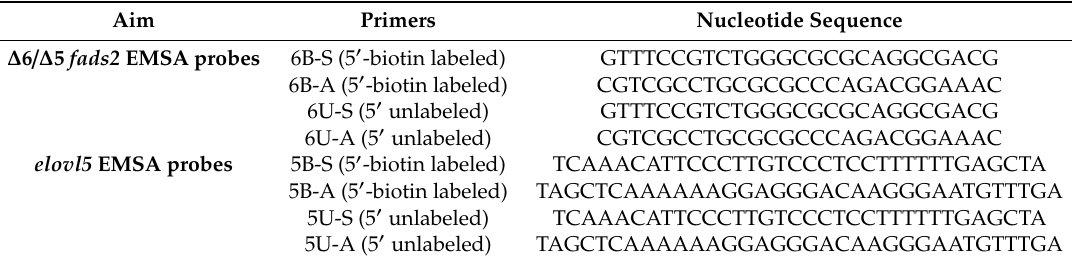
Table 5. Probes used for electrophoretic mobility shift assay